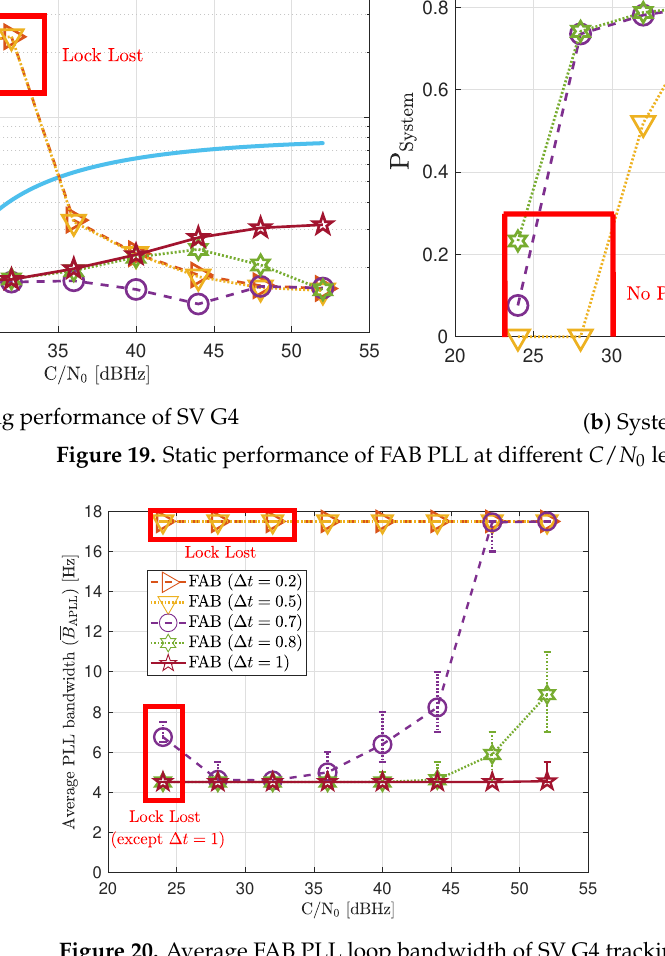
Figure 20. Average FAB PLL loop bandwidth of SV G4 trackingin static scenario. The added error bars indicate the maximum and minimum estimated loop bandwidth during the entire simulation. If ∆ t is less than 0.5 s, the average loop bandwidth is around 17.5 Hz for all the C / N 0 levels. The estimated loop bandwidth goes beyond 18 Hz,